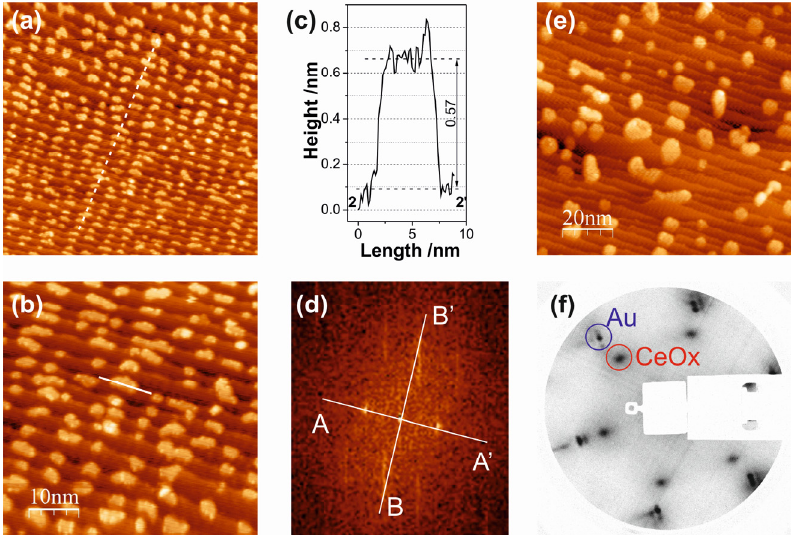
Figure 4. STM images of 0.14 ML ceria on Au(788), deposited at 473 K and postoxidized at 473 K in 5 × 10 − 7 mbar O 2 ( a ) (100 × 100) nm 2 ; V S = 2.2 V; I T = 22.1 pA. ( b ) (50 × 50) nm 2 ; V S = 2.2 V; I T = 22.1 pA). ( c ) Line scan along the solid line in the STM image ( b ). ( d ) Fast Fourier transform (FFT) representation of the STM image ( a ); A-A´and B-B´ correspond to the directions parallel and perpendicular to the steps, respectively. ( e ) STM image of the surface ( a ) after annealing in 5 × 10 − 7 mbar O 2 at 823 K (100 × 100 nm 2 ; V S = 2.0 V; I T = 16.8 pA). ( f ) LEED pattern of the annealed surface ( e ) ( E P = 120 eV); Au substrate and ceria reflections are